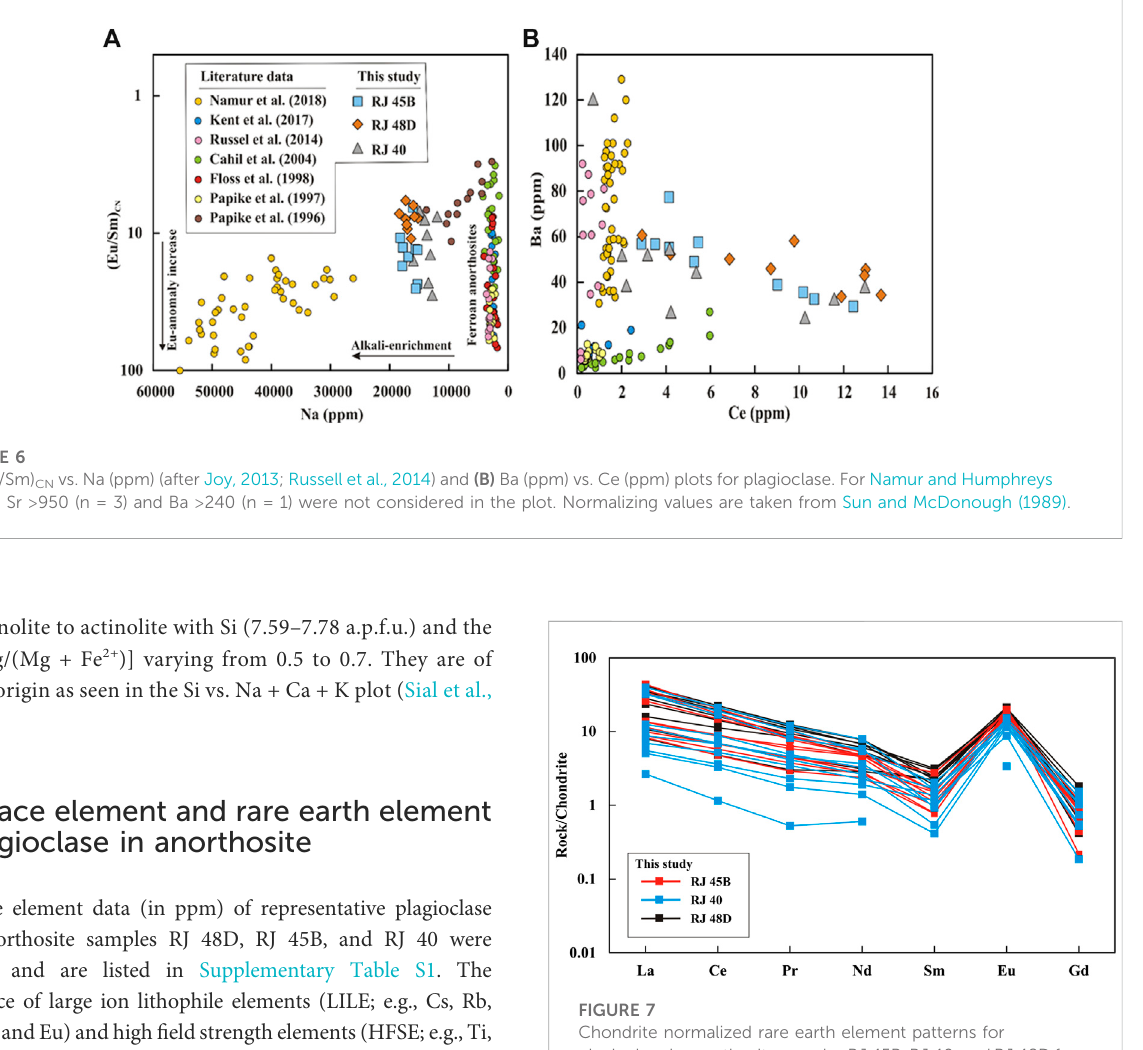
FIGURE 7 Chondrite normalized rare earth element patterns for plagioclaseinanorthositesamplesRJ45B,RJ40,andRJ48Dfrom the Chotanagpur Granite Gneiss Complex. Normalizing values are taken from Sun and McDonough